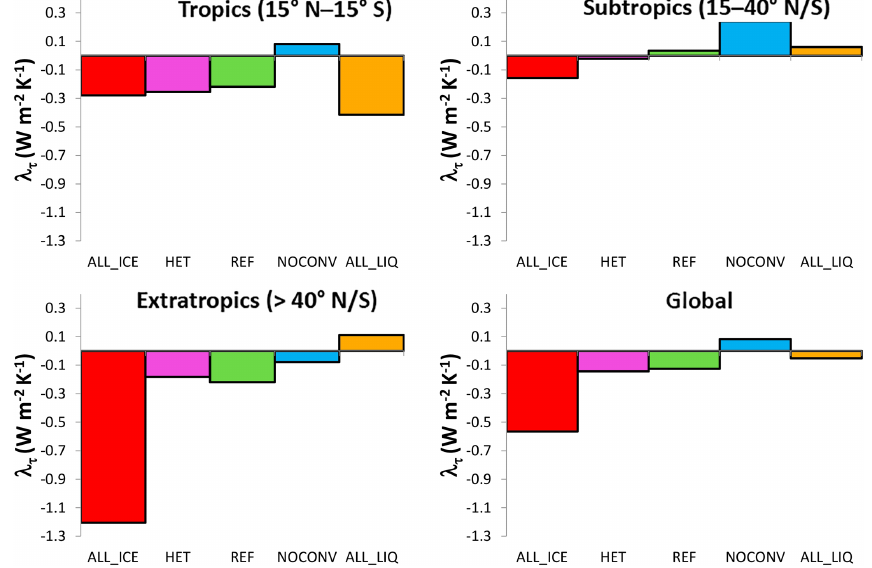
Figure 8. Tropical, subtropical, extratropical, and global cloud optical depth feedback parameter λ τ in Wm − 2 K − 1 for the sensitivity simulations described in Table